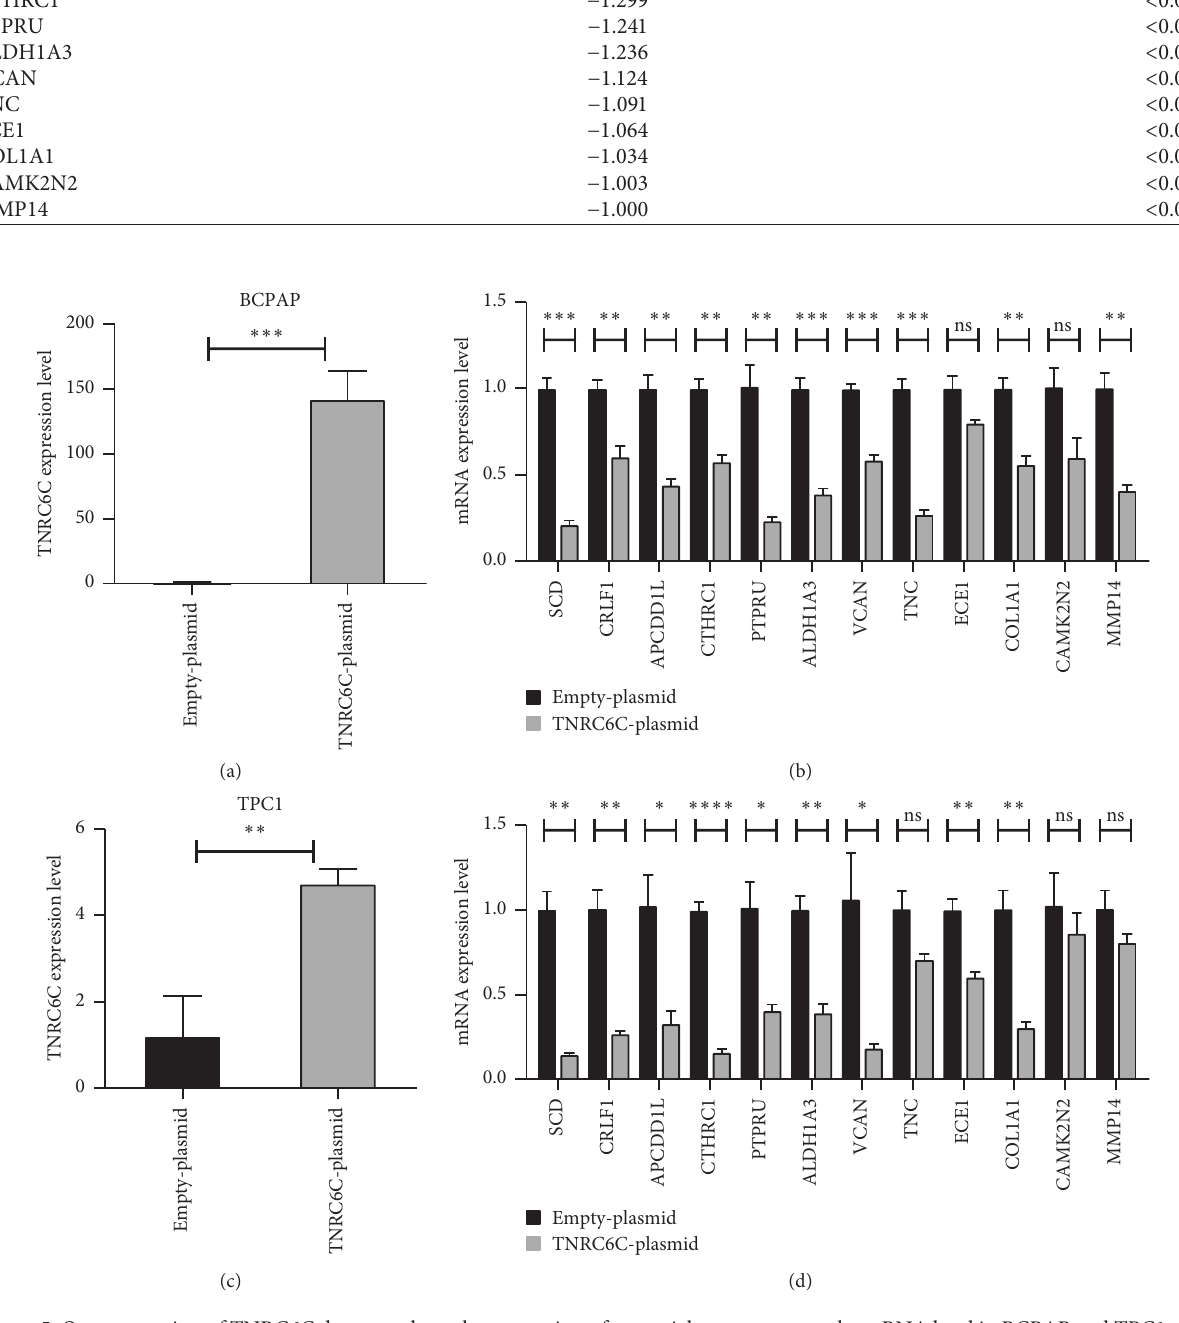
Figure 5: Overexpression of TNRC6C downregulates the expression of potential target genes at the mRNA level in BCPAP and TPC1 cells. (a) The relative mRNA level of TNRC6C in TNRC6C overexpressed BCPAP cells and control BCPAP cells. (b) The relative mRNA levels of potential target genes in TNRC6C overexpressed BCPAP cells and control BCPAP cells. (c) The relative mRNA level of TNRC6C in TNRC6C overexpressed TPC1 cells and control TPC1 cells. (d) The relative mRNA levels of potential target genes in TNRC6C over- expressed TPC1 cells and control TPC1 cells. ∗ P < 0 . 05; ∗∗ P < 0 . 01; ∗∗∗ P < 0 . 001; ∗∗∗∗ P < 0 . 0001; ns, not